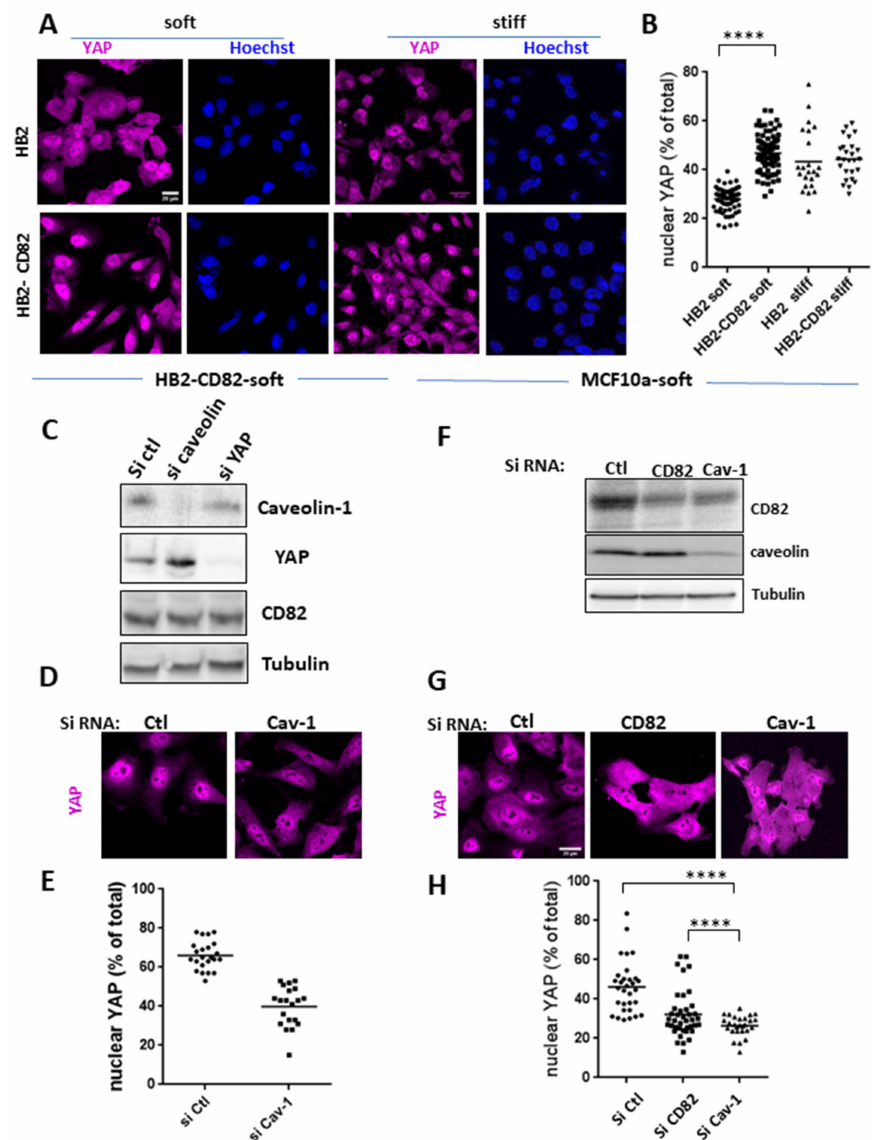
Figure 4. CD82 regulates caveolin-dependent YAP nuclear translocation. ( A ) Glass coverslips were coated with (soft, 1 kPa) or without (stiff, GPa) silicone gels then with laminin. HB2 and HB2-CD82 cells were cultivated overnight on these coverslips, then fixed and labelled with YAP antibodies or Hoestch to visualize nuclei (soft silicon: n = 73 and 84 cells in HB2 and HB2-CD82 cells, respectively, n = 10 experiments; stiff silicon: n = 23 and 26 cells, n = 4, respectively). Bar = 20 µ m. ( B ) Nuclear YAP expressed as a percentage of the total amount; **** p < 0.0001 ns: non-significant. ( C ) Caveolin, YAP and CD82 expressions in HB2-CD82 cells transfected with siRNA control (siRNA Ctl), SiRNA targeted caveolin-1 (si Cav-1) or SiRNA targeted YAP (Si YAP) grown 24 h on soft silicon gels coated with laminin and lysed. Tubulin is shown as a loading control. ( D ) Same experimental conditions as in C but cells are fixed and labelled with anti-YAP. Bar = 20 µ m. ( E ) Quantification of images